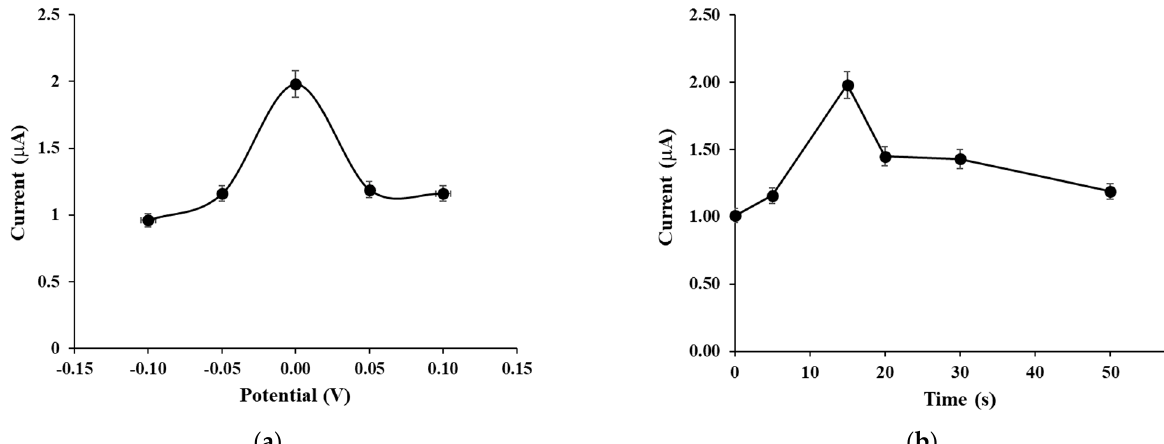
Figure 4. Effects of deposition potential ( a ) and ( b )